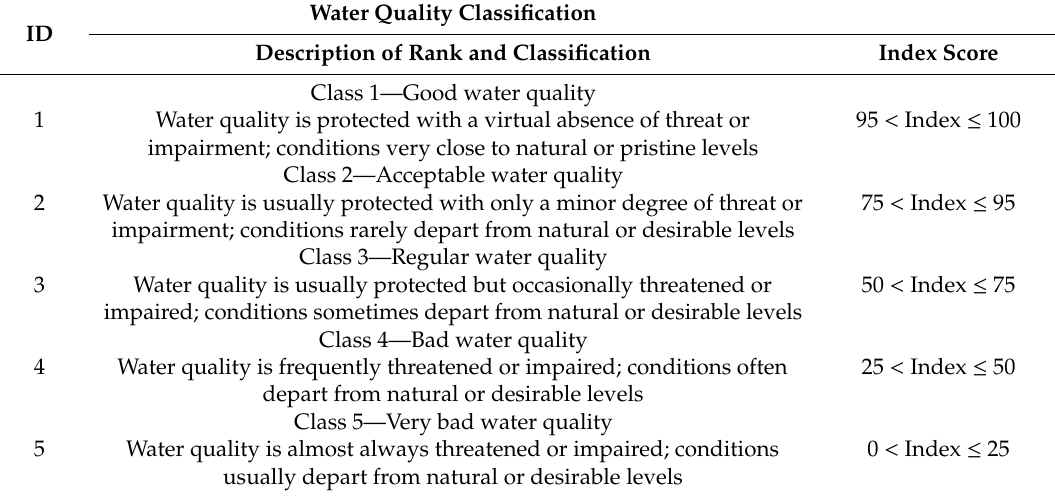
and water categorization schema suitable for assessing South African river catchments. Table 8. Index Score Classification for the Surrogate Water Quality Index for South African River